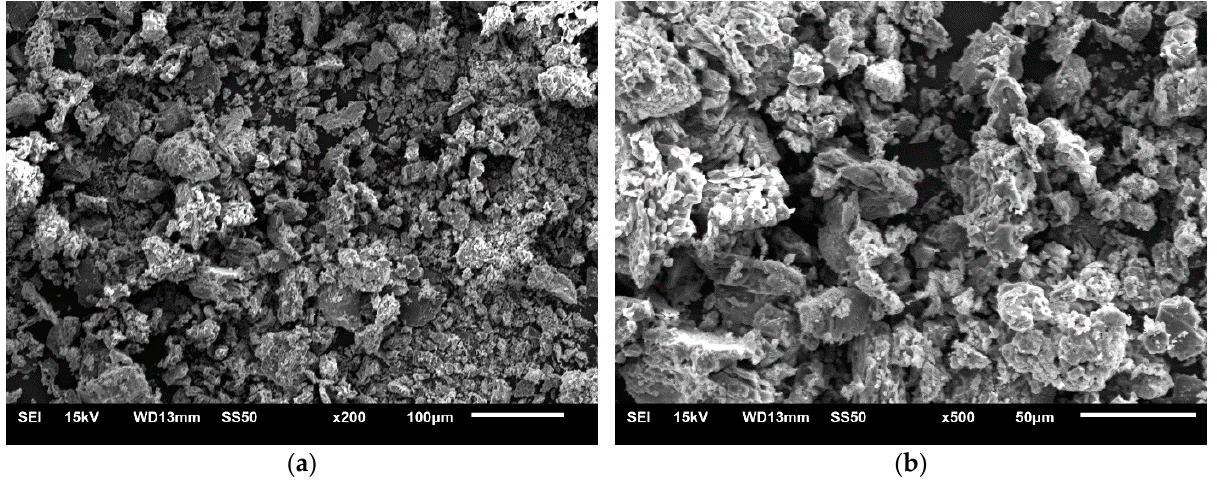
Figure 4. SEM micrographics of bare ferrite magnetic NPs: ( a ) 200 times, ( b ) 500 times . EDS analysis of bare Fe 3 O 4 shown in Figure 5 demonstrates the chemical composition and the percentage of some elements, such as 35.1% oxygen (O), 35.1% sodium (Na), 19.4% carbon (C), and 19.1% iron (Fe), in the body of the synthesized composite [22]. Further, some trace elements were identified, such as 1.4% chlorine (Cl), 0.5% copper (Cu), and 0.2% silica (Si).